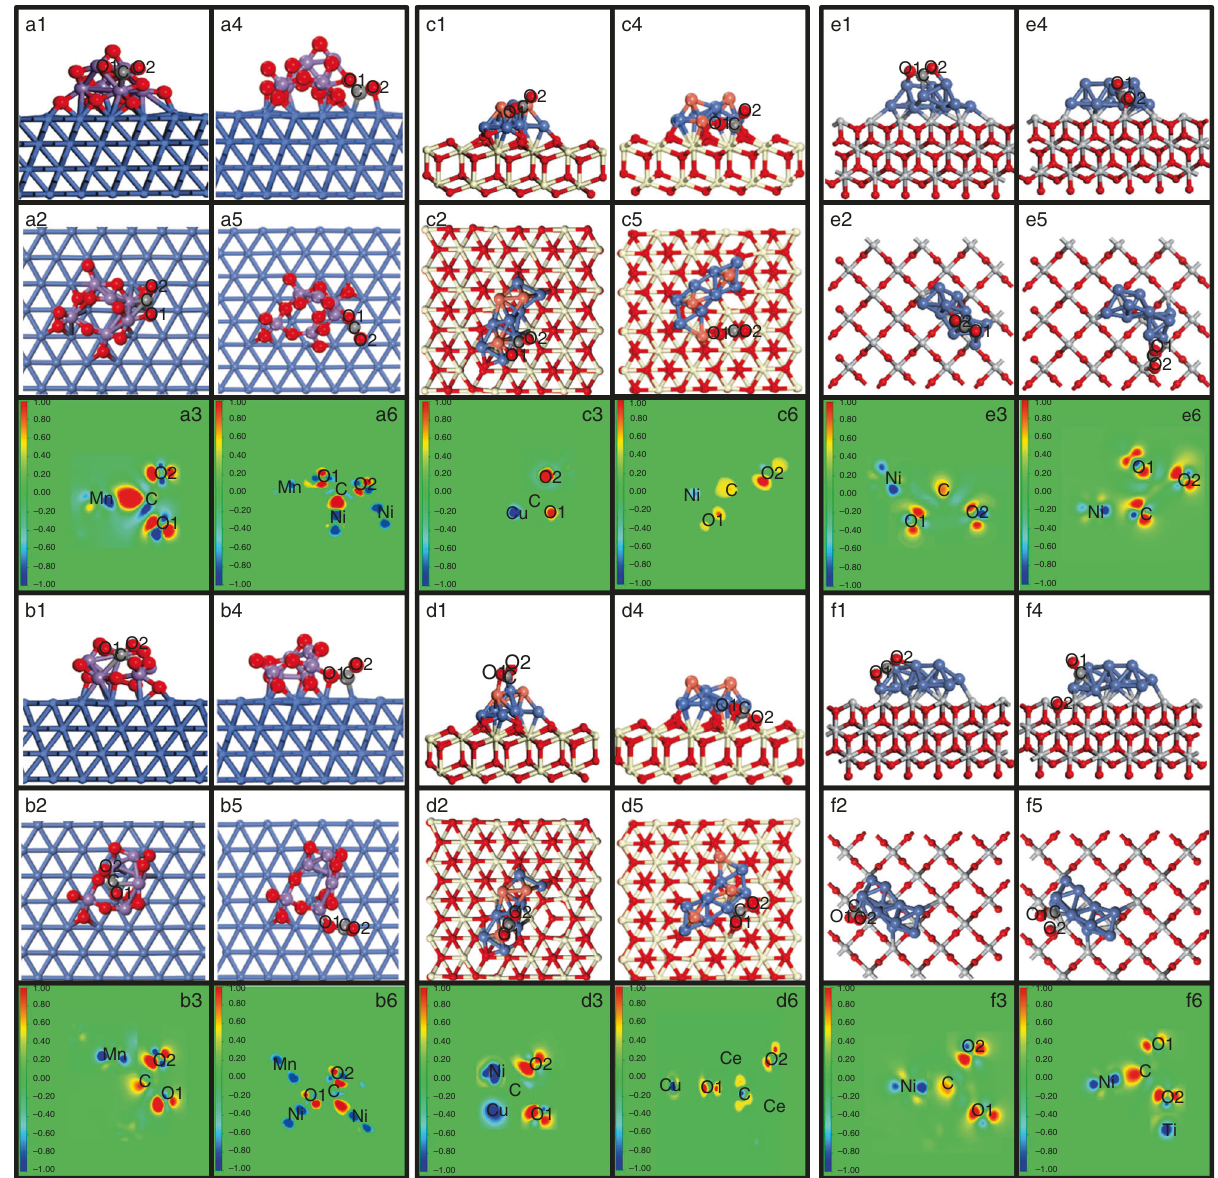
Fig. 5 Different adsorption con fi gurations of CO 2 on the system. a , b The MnO x /Ni system. c , d The Ni – Cu/CeO 2 system. e , f The Ni/TiO 2 system (top: clean surfaces, bottom: defective surfaces, 1 and 4: side views, 2 and 5: top views, 3 and 6: contour plots of electronic charge density difference). Nickel in blue, copper in orange, cerium in silvery white, titanium in pale, manganese in purple, oxygen in red, and carbon in